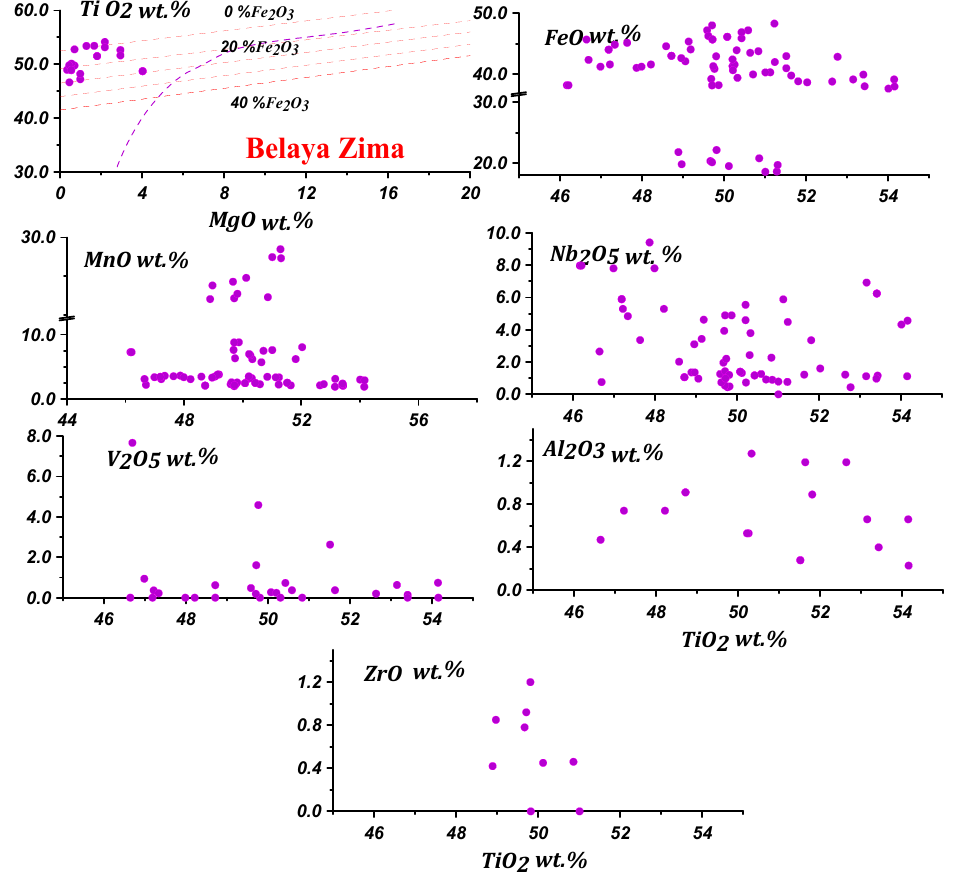
Figure 17. Variations of ilmenite compositions from BZM. The isopleth of Fe 2 O 3 after [67].